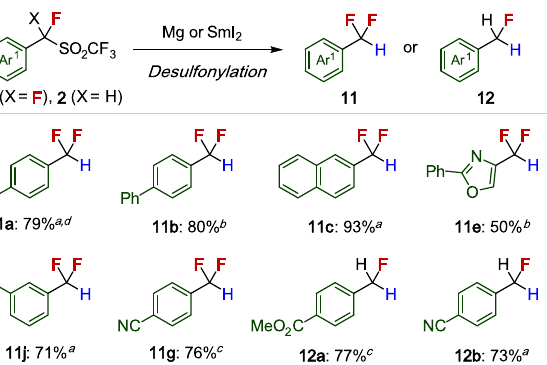
Fig. 4 Substrate scope of reductive desulfonylation of 1 and 2 . a Mg (15 equiv), NaOAc/AcOH/DMF. b Mg (25 equiv), AcOH/H 2 O/DMF. c Sml d Yield was determined by 19 F 2 (3 equiv), MeOH/THF.